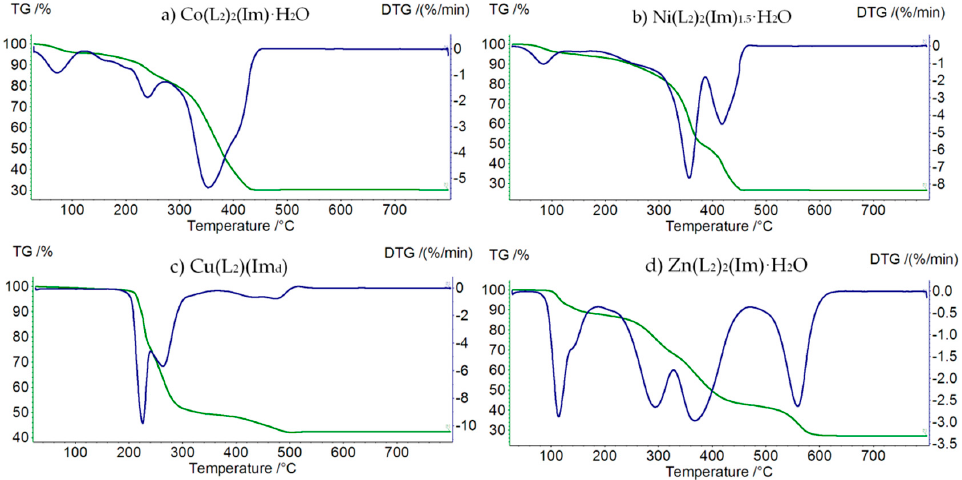
Figure 6. TG (green) and DTG (blue) curves of decomposition of: ( a ) Co(L 2 ) 2 (Im) · H 2 O, ( b ) Ni(L 2 ) 2 (Im) 1.5 · H 2 O, ( c ) Cu(L 2 )(Im d ), and ( d ) Zn(L 2 ) 2 (Im) · H 2 O. Table 8. TG-DTG analysis data of decomposition of Co(L 2 ) 2 (Im) · H 2 O. Compound/Solid Intermediate